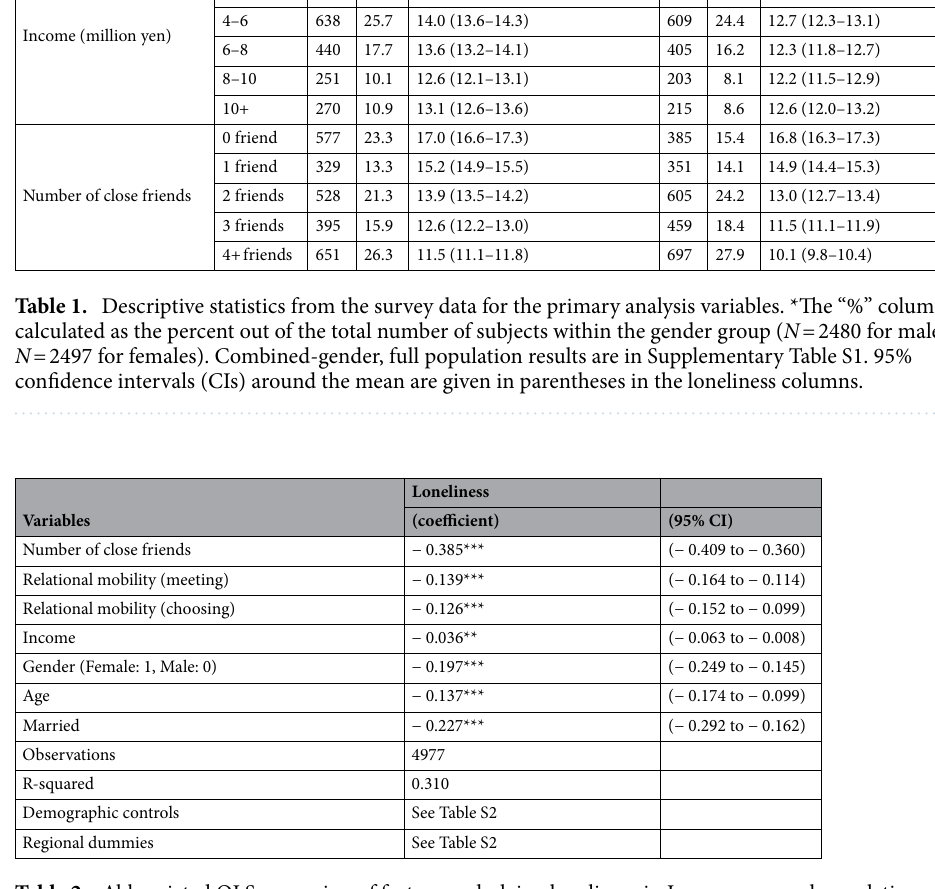
Table 2. Abbreviated OLS regression of factors underlying loneliness in Japanese general population sample. *p < 0.10; **p < 0.05; ***p < 0.01. Regression coefficients for factors underlying loneliness, with standardized regressors. Negative coefficients correspond to lower loneliness. 95% confidence intervals (95% CIs) are given in parentheses. Only coefficients for the most relevant independent variables are shown, for the full regression table see Supplementary Table